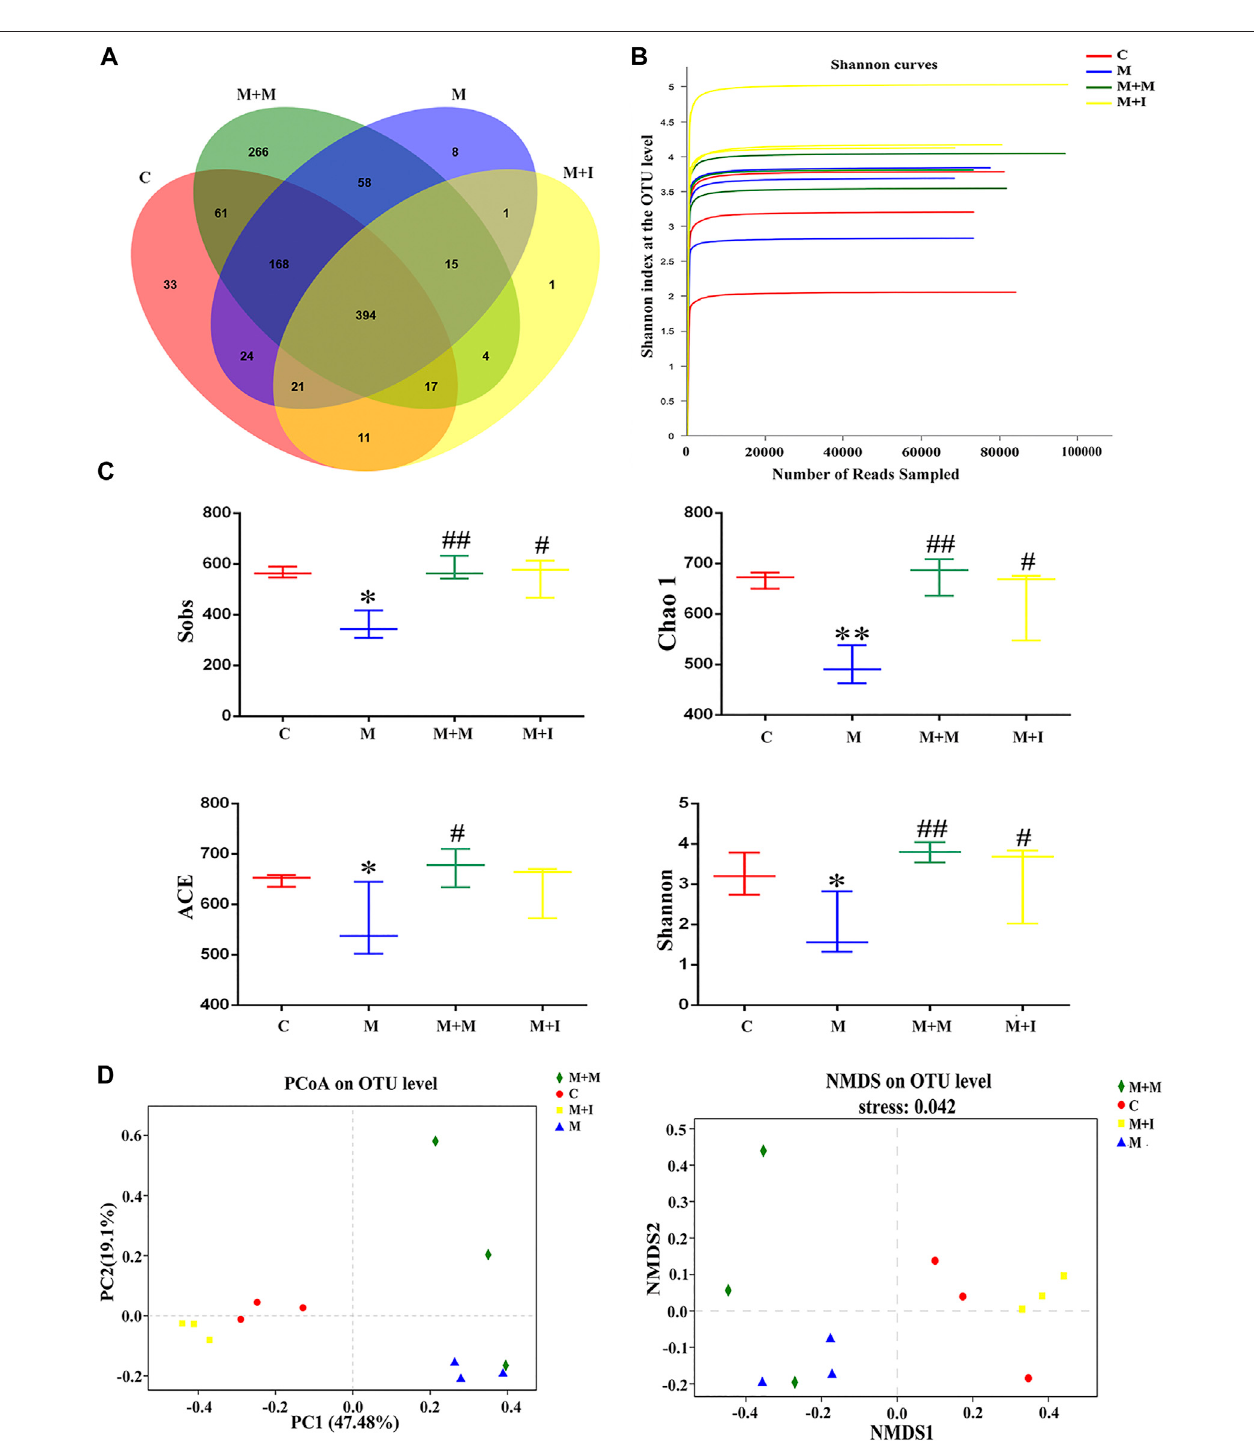
FIGURE 5 | Comparison of community structure among the fecal microbiota of the C, M, M + M, and M + I groups. (A) Venn diagram illustrating the overlap of the operational taxonomic units (OTUs) identi fi ed in the fecal microbiota of the four groups. (B) Shannon curves among the four groups. (C) Alpha diversity of the fecal microbiome among the four groups according to Sobs, Chao, ACE, and Shannon indices. (D) Beta diversity of the fecal microbiome among the four groups based on principalcoordinateanalysis(PCoA)andnonmetricmultidimensionalscaling(NMDS).* p < 0.05,** p < 0.01 vs theCgroup; # p < 0.05, ## p < 0.01 vs theMgroup.C: control group; M: morphine group; M + M: morphine + methadone group; M + I: morphine + isorhynchophylline group.